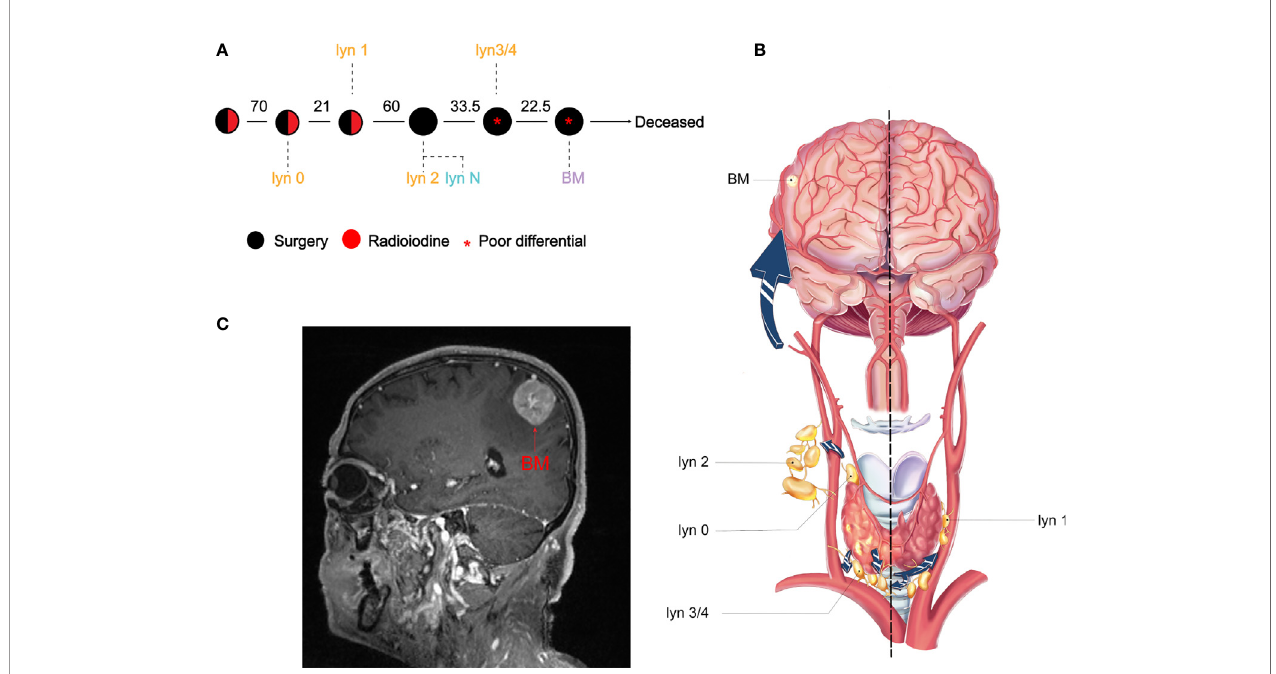
FIGURE 1 | Illustration of treatment course and metastatic pattern PTC patient. (A) Clinical course is shown from the time of surgical resection of primary tumors to death. Circles represented treatment, black and red represented surgery and radioiodine, respectively. Red star indicated that poor differential component was found in the resected samples. The interval between two circles was shown in months; (B) Illustration of thyroid cancer and metastatic routes. lyn 0 – 4 represented the metastatic lymph nodes and BM represented brain metastasis; (C) Magnetic resonance imaging of the